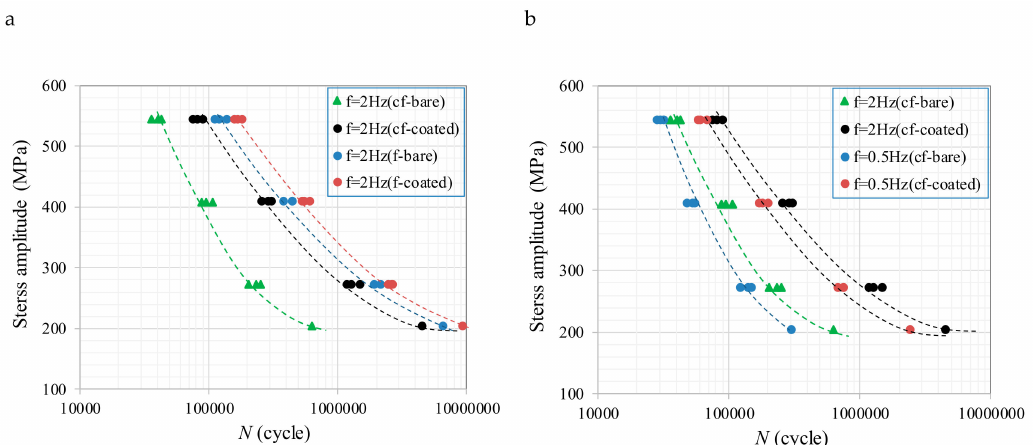
Figure 5. Comparison between fatigue and corrosion fatigue life in number of failure cycles: ( a ) Fatigue and corrosion fatigue life at f = 2 Hz and ( b ) load frequency on corrosion fatigue